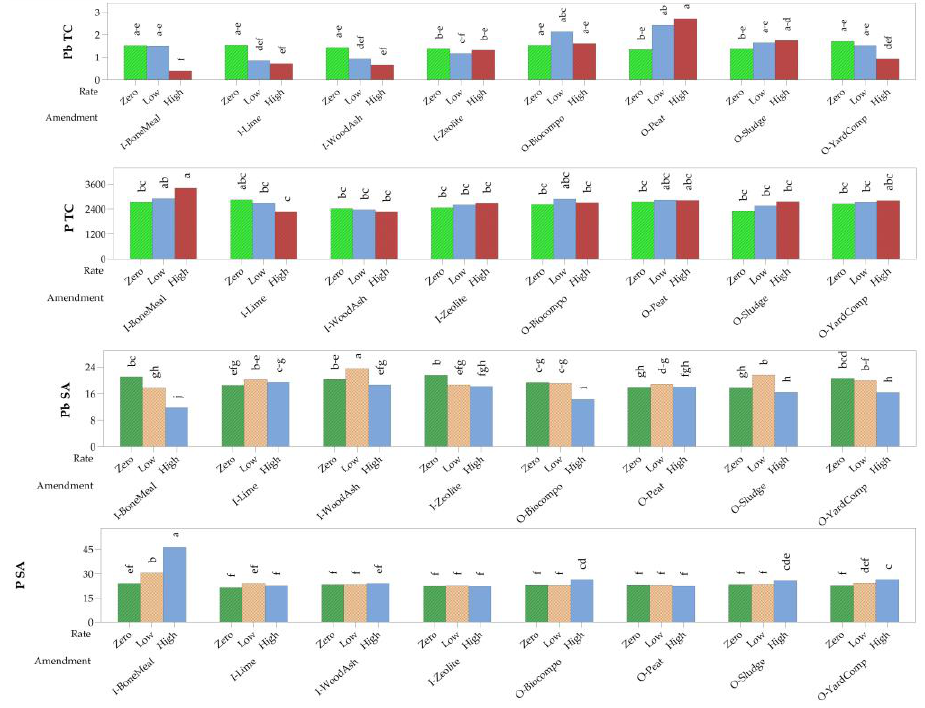
Figure 3. Amendment*Rate Interaction effect on Pb tissue concentration (TC), P TC, Pb soil available (Pb SA), and P SA. Within each response variable, means sharing the same letter are not significantly different.